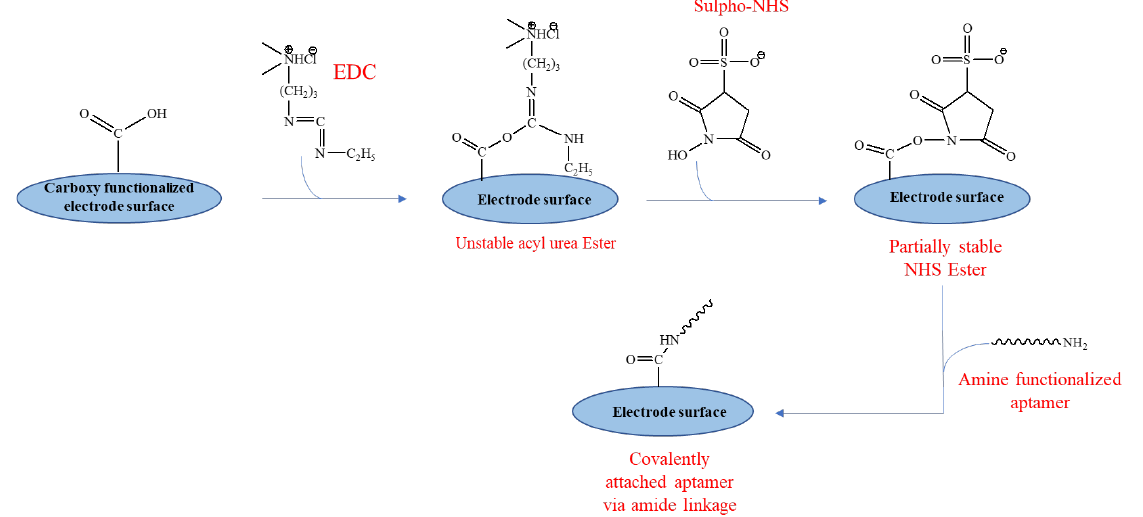
Figure 3. Schematic representation of EDC/NHS chemistry.